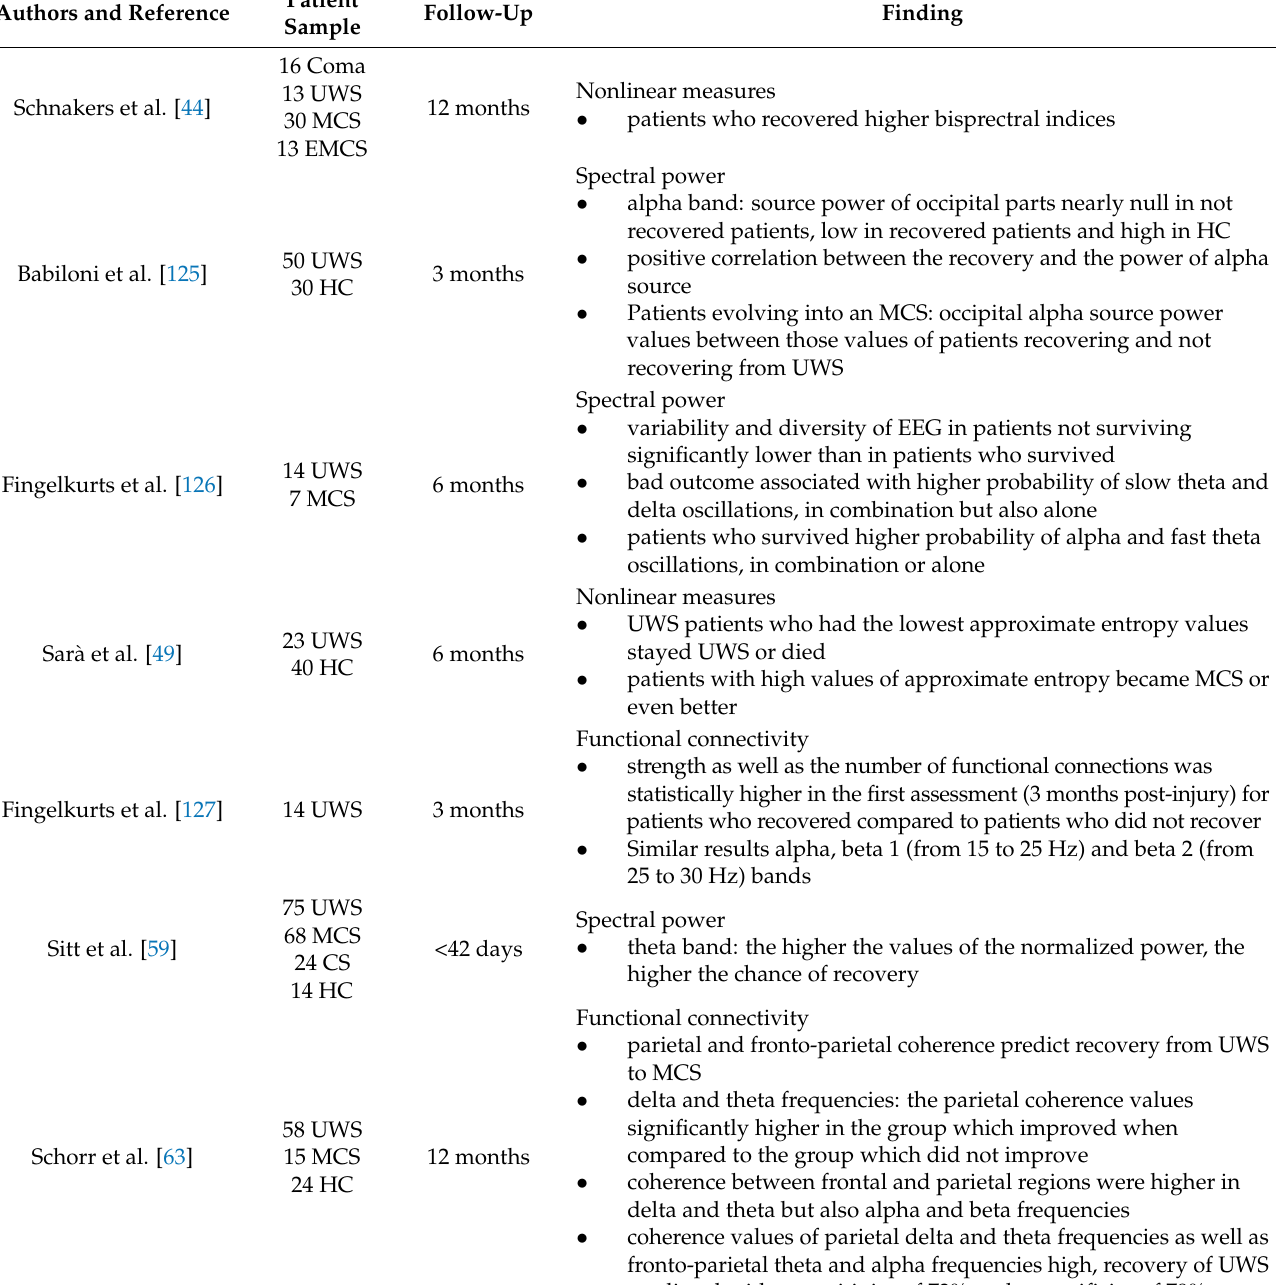
Table 4. Overview of findings for prognosis and resting-state EEG; abbreviations can be found in Abbreviation. Authors and